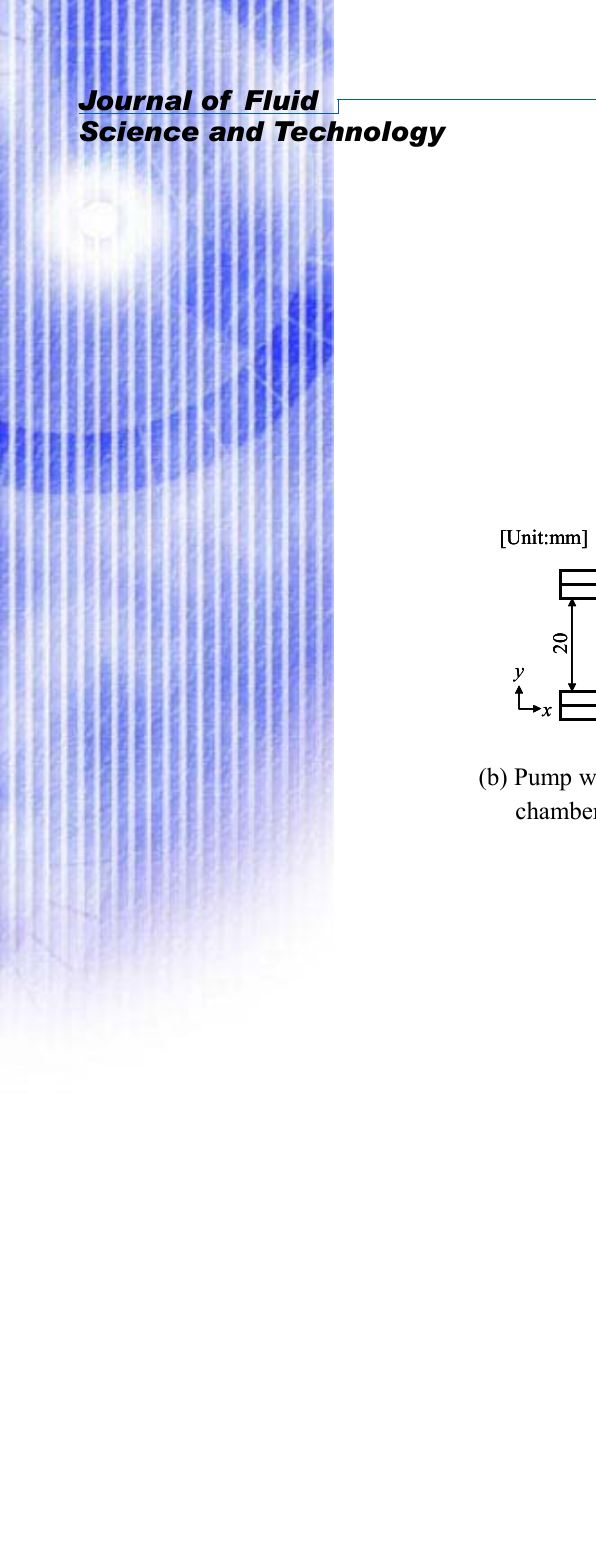
Fig.2 Schematic of experimental apparatus